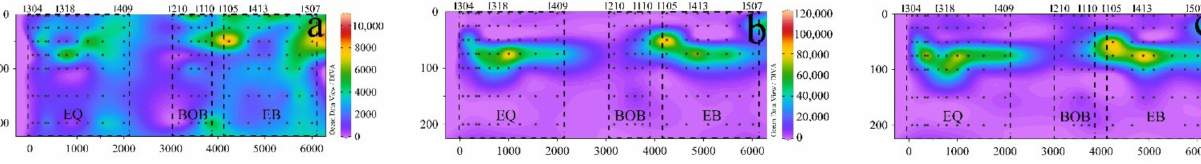
Figure 5. The vertical distribution of pico. ( a ) Syn , ( b ) Pro and ( c ) PEuks . Bay of Bengal (BOB), the Equator (EQ), and the eastern border of the Indian Ocean near Sumatra (EB). Synechococcus ( Syn ), Prochlorococcus ( Pro ), and Picoeukaryotes ( PEuks